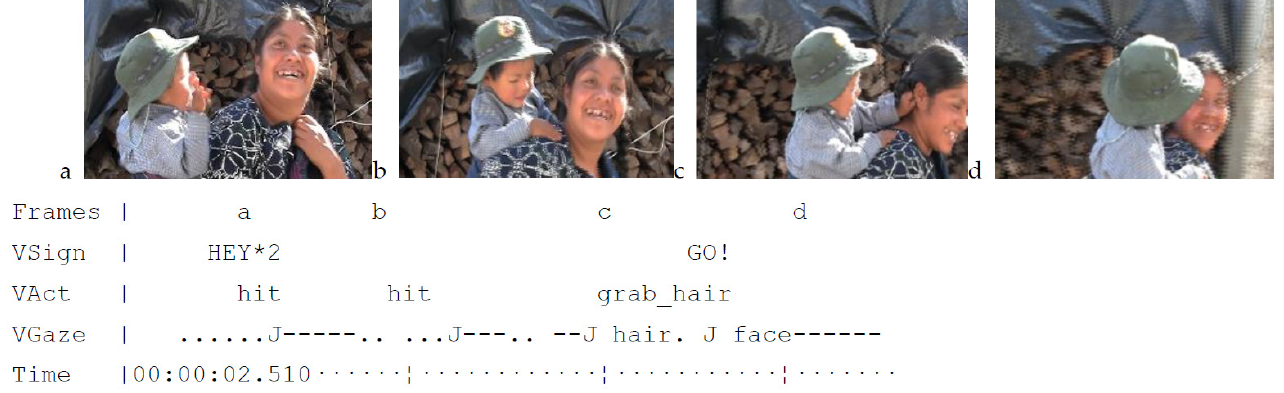
Figure 22. Vic at 27 mos. was as a bimodal interactive tyrant. First, ( a ) Vic tried a signed HEY1, augmented by forcefully dropping his hand onto his mother’s shoulder. A second time, as she hiked him higher onto her back and strapped him in more tightly, ( b ) he tried again, putting more effort into both the blow and the hand sign. Finally, ( c ) he reached forward with his left hand and grabbed his mother’s hair just behind her ear, forcefully pulled her head around where she could see him, and only then ( d ) signed that he was anxious to go, which was doubtless already obvious to Jane.